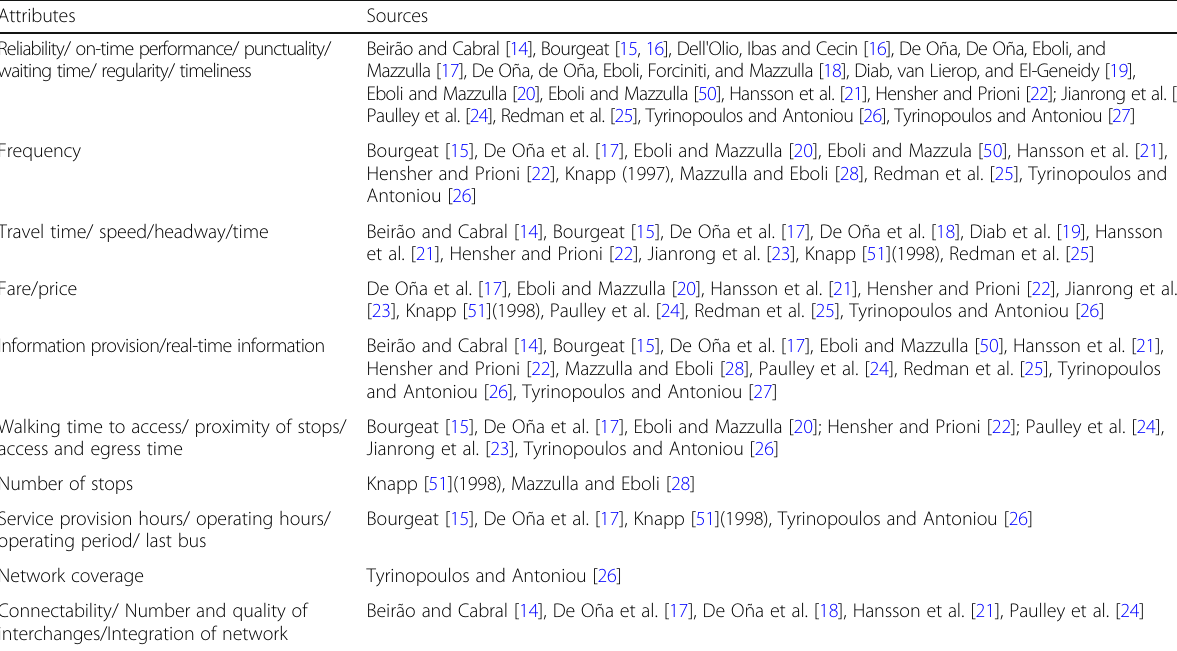
Table 1 Results of literature review concerning attributes affecting travelers ’ perception of bus service quality